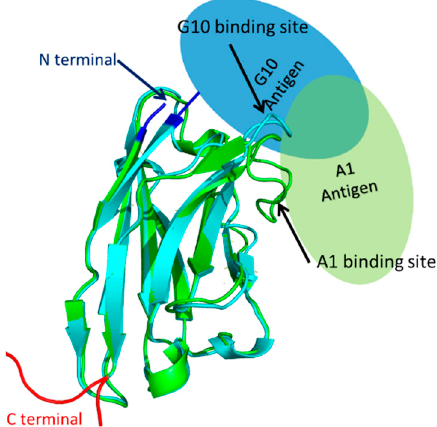
Figure 4. Aligned homology models of single domain antibodies with presumed antigen binding configuration. The ribbon diagrams of the homology structures of sdAb EA1 / A1 (cyan, based on pdb ID 6GLW) and sdAb EA1 / G10 (green, based on pdb ID 5F10) were aligned using Pymol. The ovals show the presumed binding positions of the EA1 antigen for sdAb EA1 / A1 (light blue) or sdAb EA1 / G10 (light green). The N- and C-terminal regions of the sdAbs are also noted in blue and red, respectively. See Figure S2 for the individual pdb bank structures used to support the orientations of antigen binding.